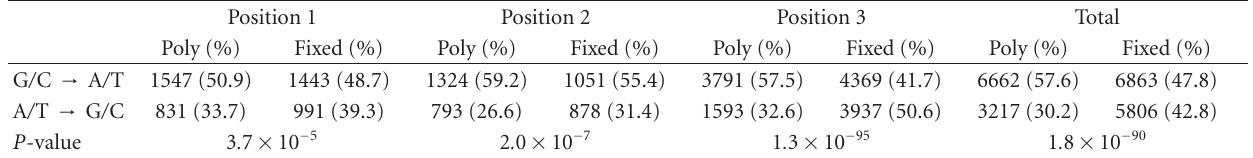
Table 1: Comparison of mutations G/C → A/T and A/T → G/C at the polymorphic and fixed sites in coding